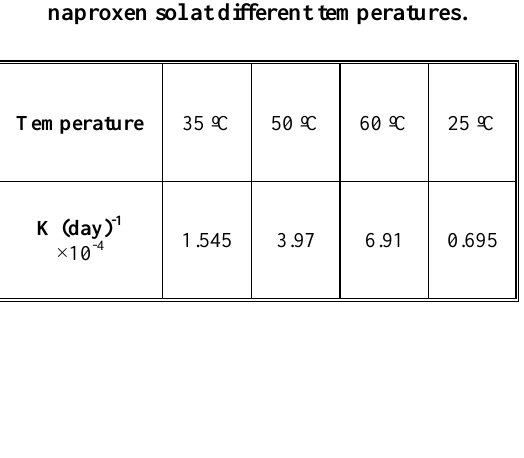
Table (2): Degradation rate constants (K) of naproxen sol at different temperatures.